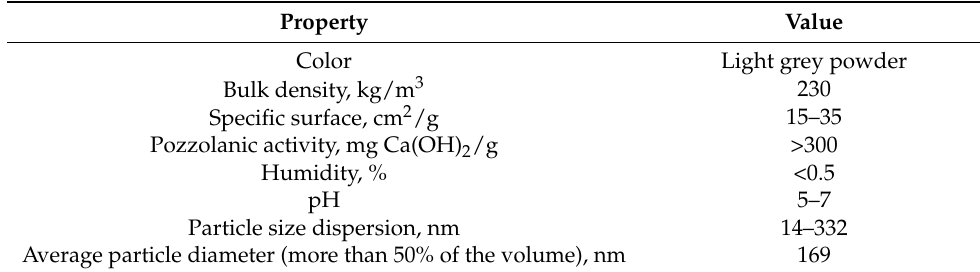
Table 4. Physical properties of silica